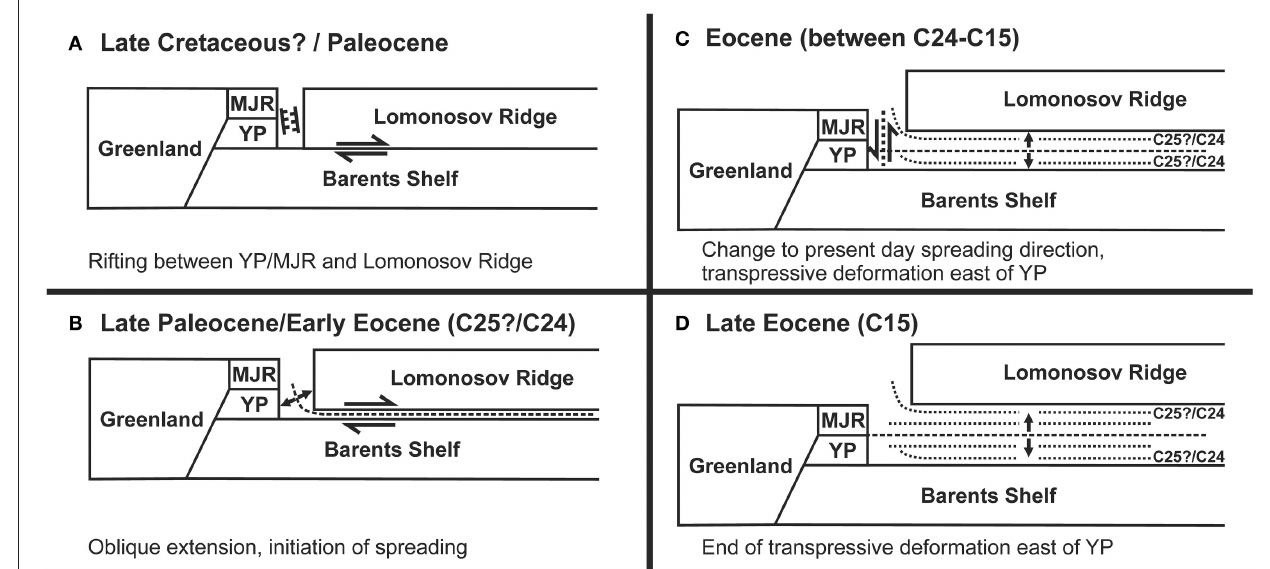
FIGURE 7 | Sketch depicting the tectonic evolution of the western Eurasian Basin (not to scale). (A) Rifting between Yermak Plateau (YP)/Morris Jesup Rise (MJR) and the Lomonosov Ridge, right-lateral movement between the Barents Shelf and the Lomonosov Ridge (adopted from Minakov et al., 2013). (B) Initiation of spreading, anomalies C25?/C24 are bent northward between YP/MJR and the Lomonosov Ridge. (C) The northward displacement of the Lomonosov Ridge along the Yermak Plateau might have resulted in transpression. (D) The Gakkel Ridge has passed the YP, thus right-lateral movement and transpression stopped. The sketch shows the situation just before break-up of YP and